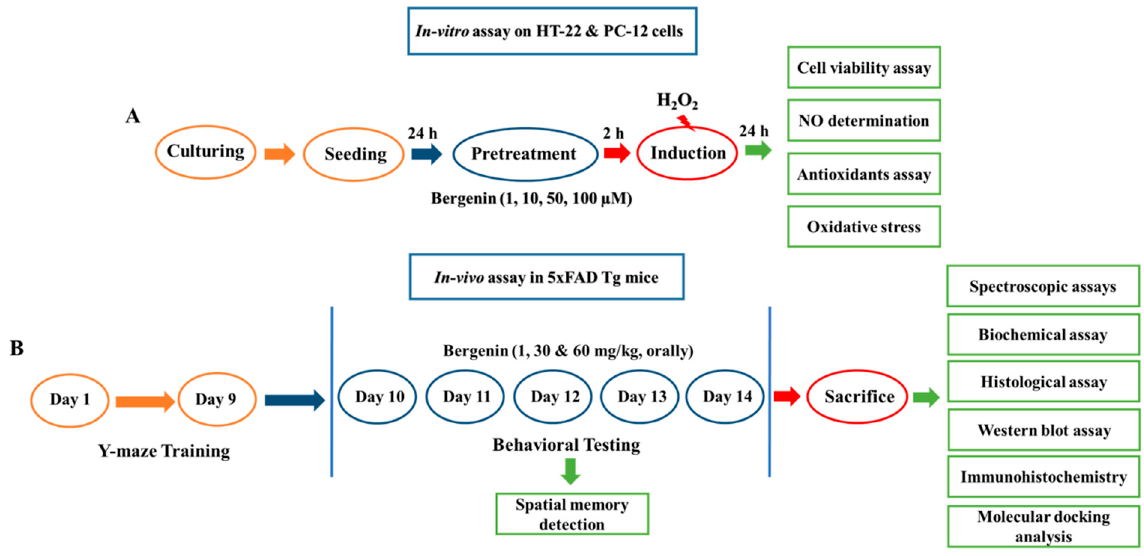
Figure 15. Schematic diagram representing the experimental design. ( A ) Preliminarily in-vitro assay was performed on HT-22 and PC-12 cells. ( B ) The in vivo assay was performed on 5xFAD Tg mouse model.